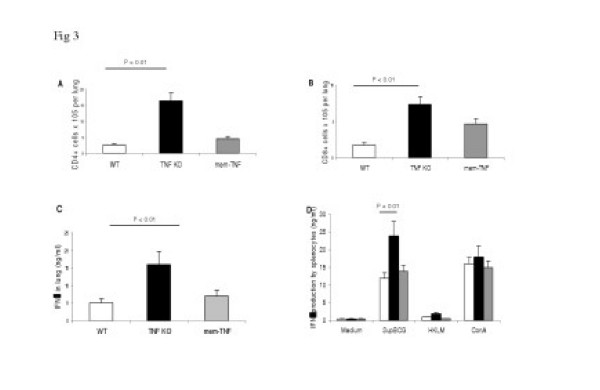
Augmented CD4 and CD8 T cell recruitment, pulmonary IFNγ production and antigen-specific T cell response in infected TNF-KO mice are corrected in mem-TNF mice. Recruitment of CD4 (A) and CD8 T cells (B) in the lung of WT, mem-TNF and TNF-KO mice infected with Mtb (100 CFU). Lymphocytes were obtained form lungs from Mtb infected mice at 30 days post infection as described in Materials and Methods. IFNγ levels in lung homogenates at 30 days of infection (C): Increased IFNγ levels in TNF KO mice, which were lower and comparable in mem-TNF and WT mice. Antigen-specific IFNγ production by SupBCG restimulated splenocytes from mem-TNF and TNF-KO mice, but augmented response in TNF-KO splenocytes (D). Data are representative of two independent experiment (n = 4 mice, mean ± SD).